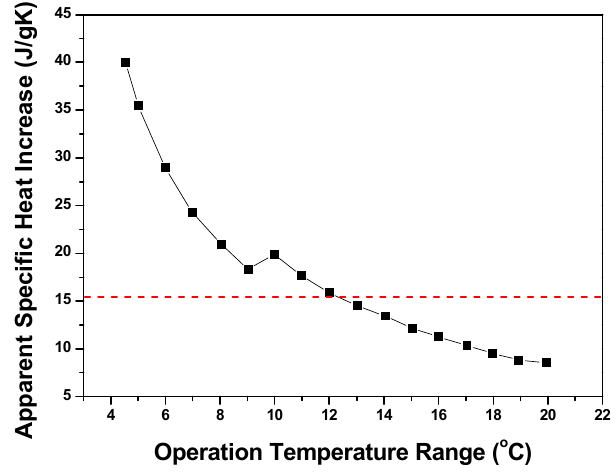
Figure 3. Latent Heat Increase for Enhanced PCM System [46].